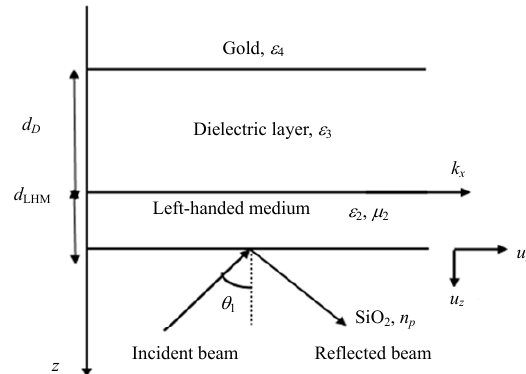
Fig. 1 Multilayer configuration under study: an LHM